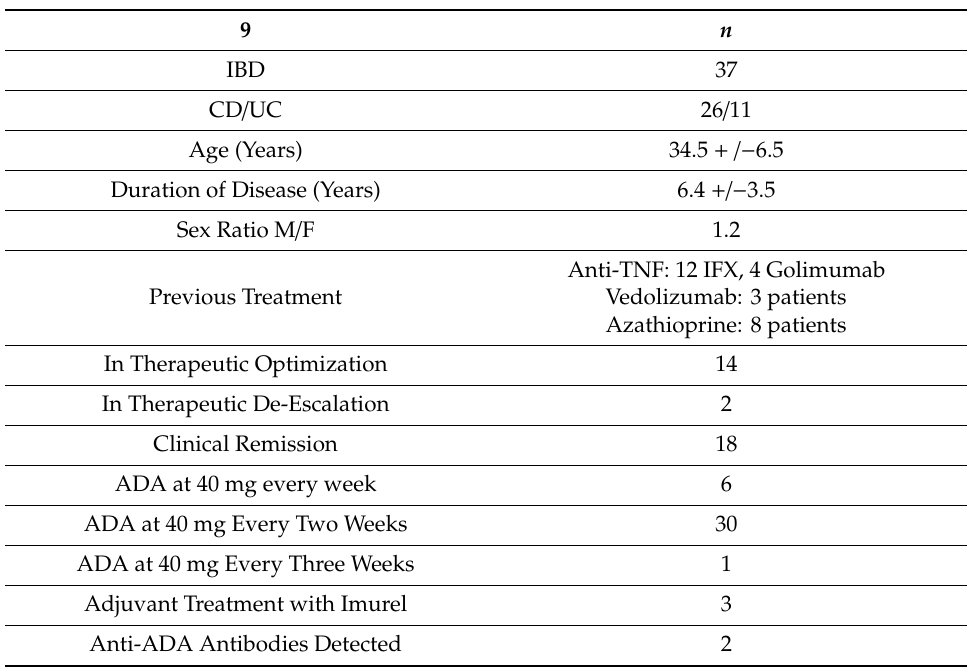
Table 2. Clinical characteristics of the prospective IBD cohort. IBD: Inflammatory Bowel Disease; CD: Crohn’s disease; UC: ulcerative colitis; IFX: infliximab; TNF: tumor necrosis factor; ADA: adalimumab; M: Men; F: Female.